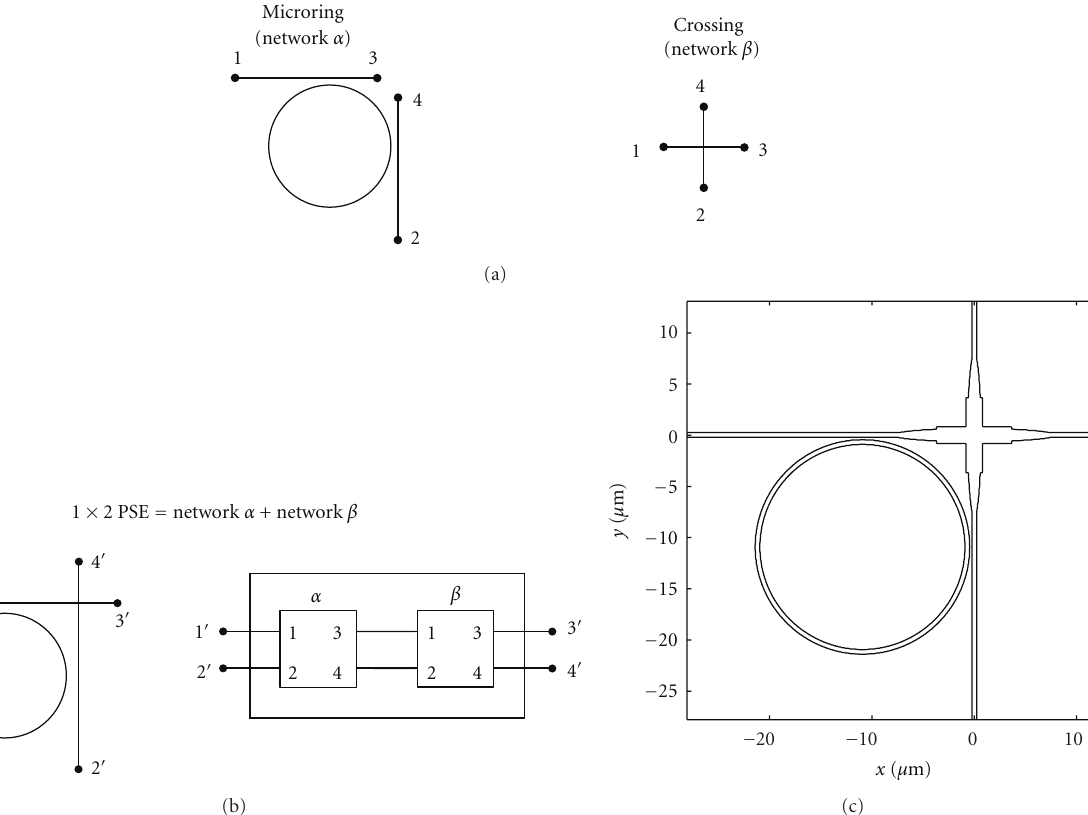
Figure 2: ((a)-left) Sketch of a microring resonator with orthogonal access waveguides. ((a)-right) Sketch of an orthogonal planar crossing. (b) The 1 × 2 PSE can be considered as the cascading of the microring α with the crossing β . If the wavelength of the optical carrier signal is resonant with the microring, the data stream on the Port 1 (cid:3) is routed toward Port 2 (cid:3) ; if the optical signal is not resonant, the data stream is routed to Port 3 (cid:3) . Dually, a signal coming from Port 4 (cid:3) is routed to Port 3 (cid:3) if resonant, while continuing to Port 2 (cid:3) if out of resonance. The device is bidirectional, that is, each of the ports can act as input or output, but not simultaneously. (c) Representation of the PSE as it appears when discretized inside the 2D-FDTD code; in this case, the transmission at the intersection between the waveguides is optimized using an MMI-based